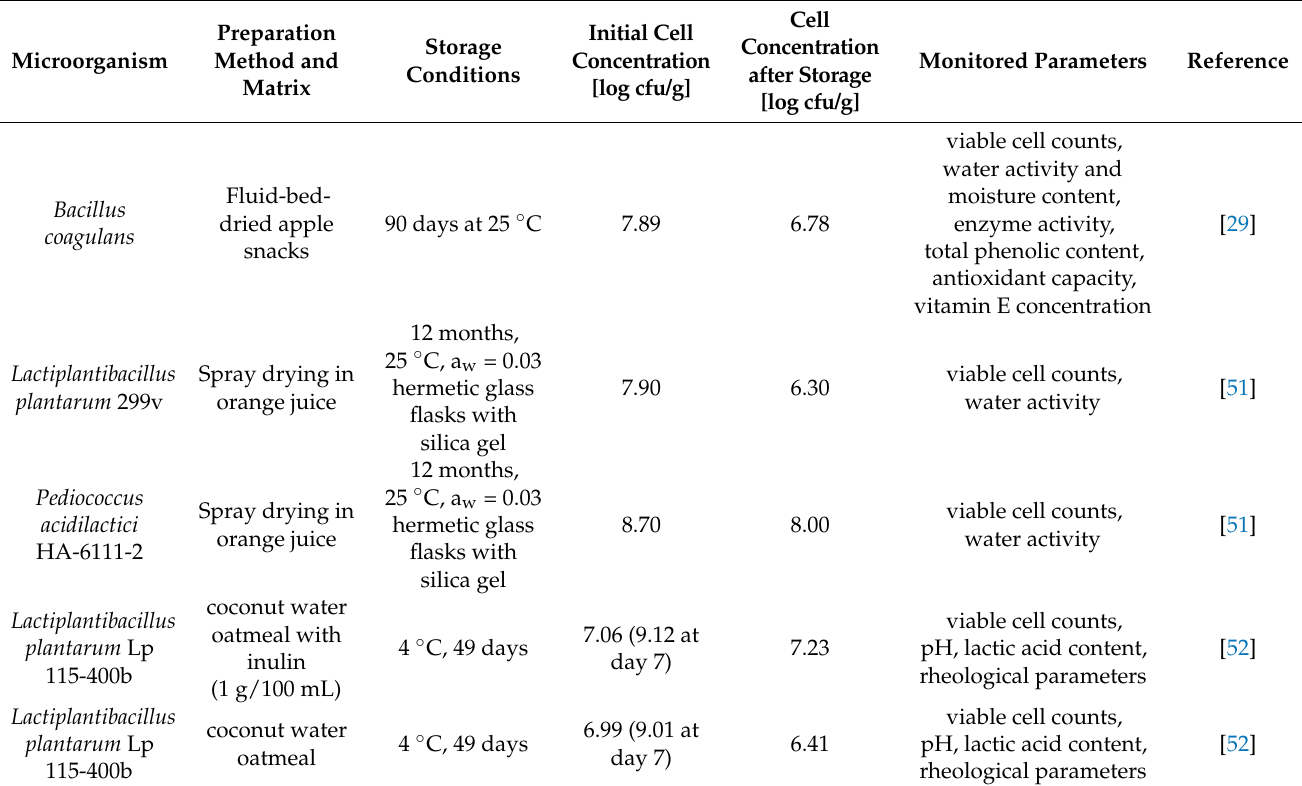
Table 3. Shelf-life and viability of